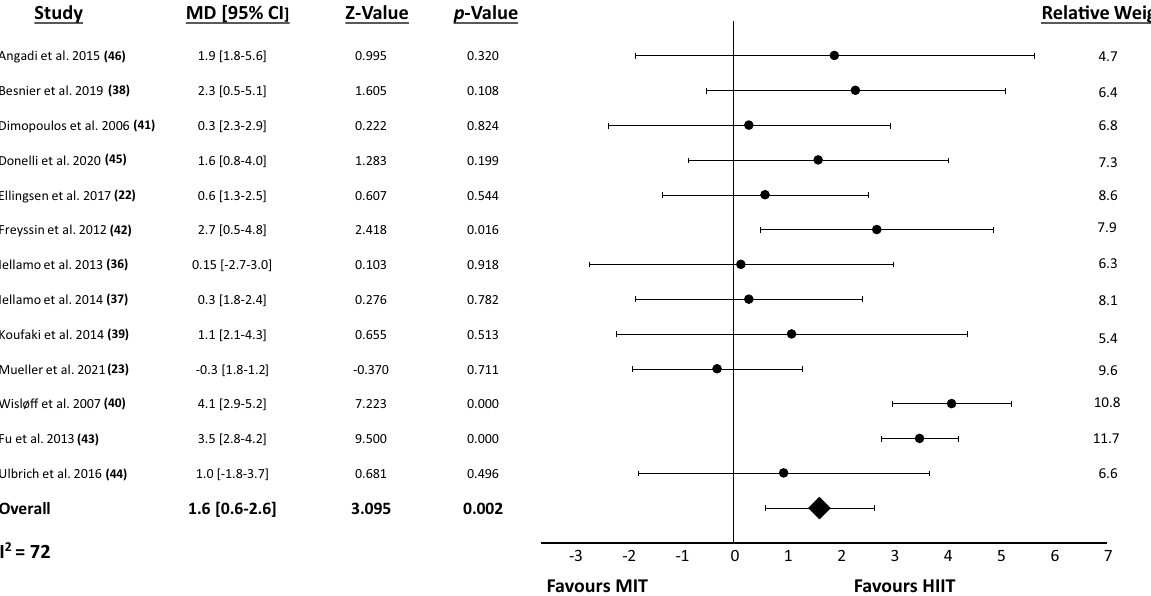
Fig. 3 Random-effects meta-analysis of the weighted mean difference in peak VO 2 between MIT and HIIT. MIT, Moderate intensity training; HIIT, high-intensity interval training; MD, Mean Difference; VO2, peak oxygen uptake; IV, weighted mean